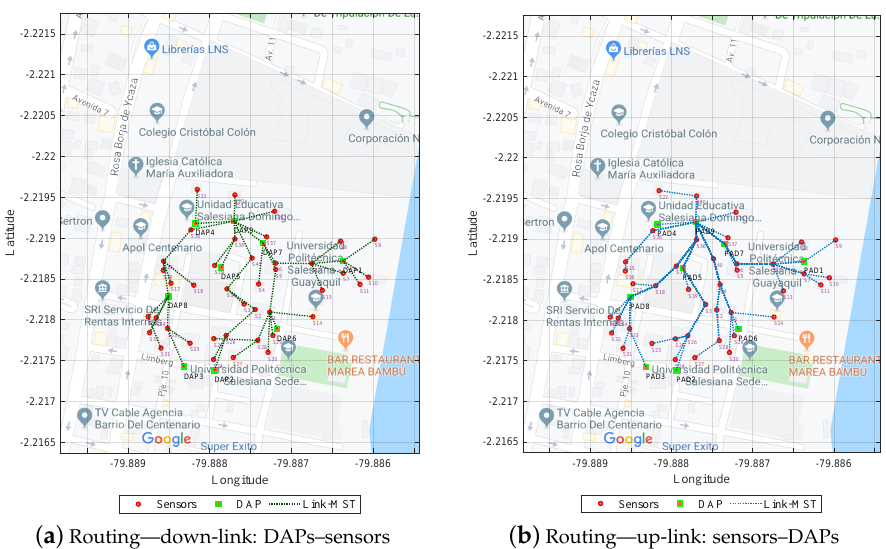
Figure 4. Optimal routing based on the Dijkstra